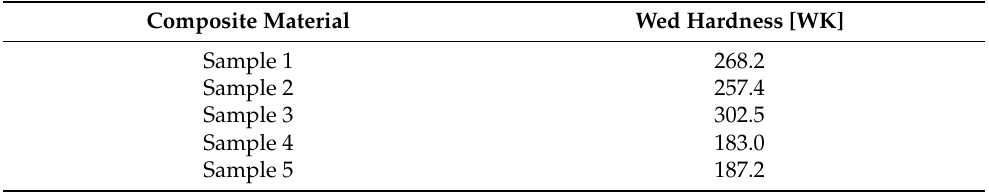
Table 3. Average hardness results from the ball indentation